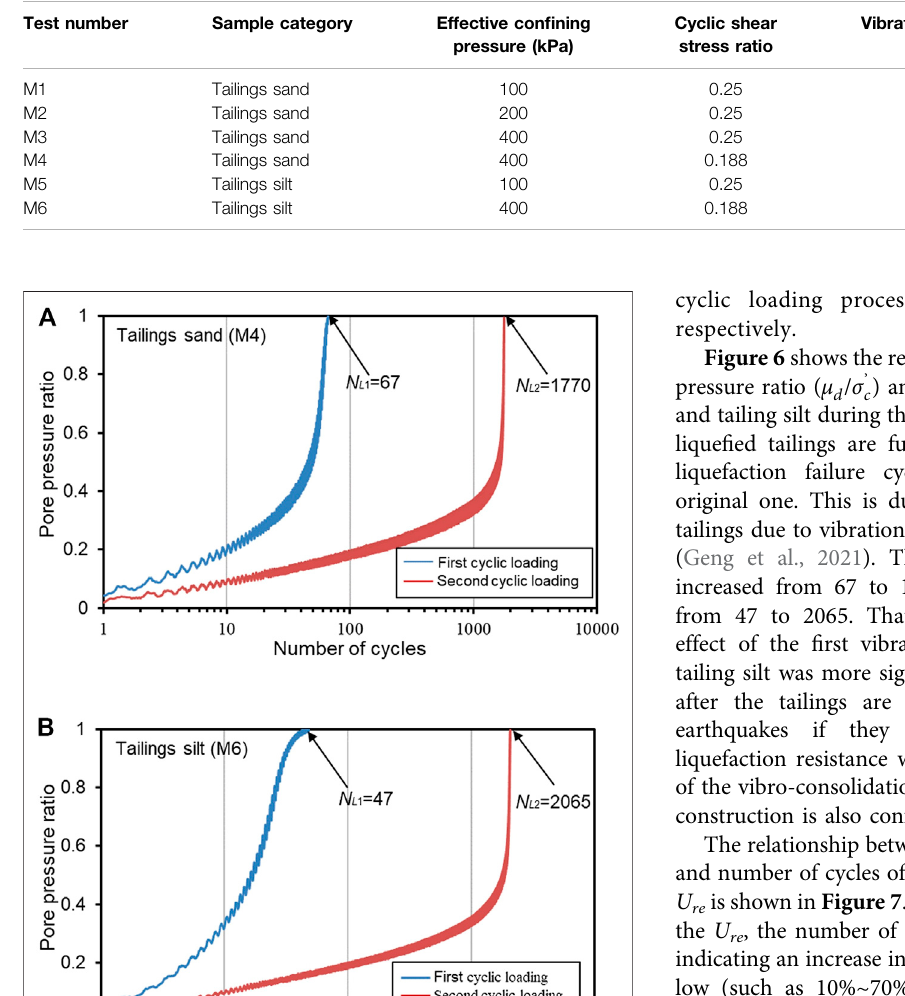
Frontiers in Earth Science |